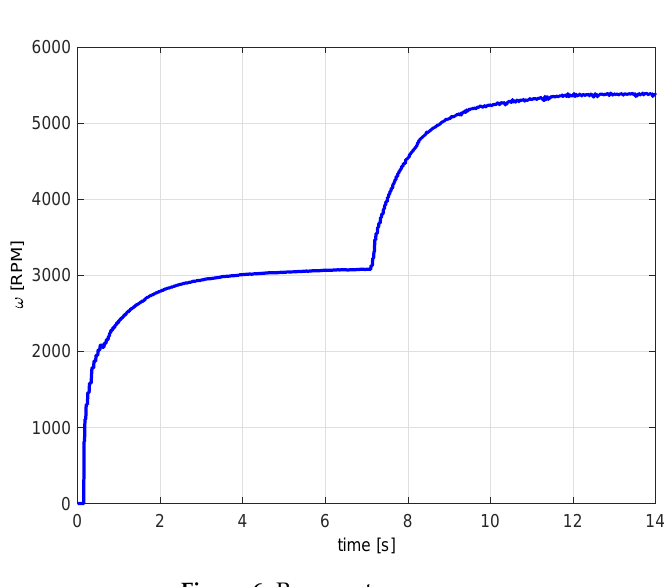
Figure 6. Process